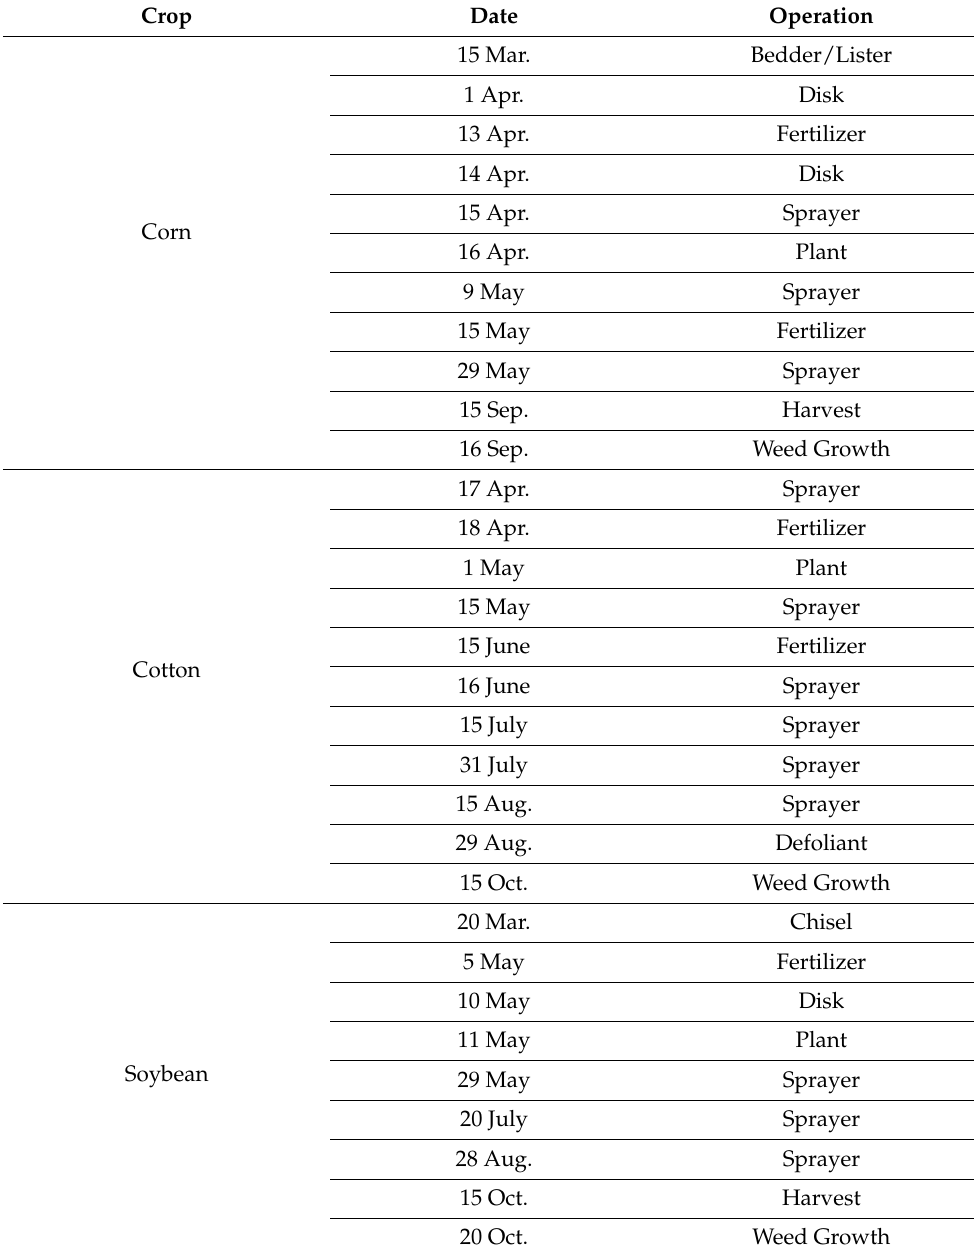
Table 2. Example of the annual management schedule for three major crops in the study